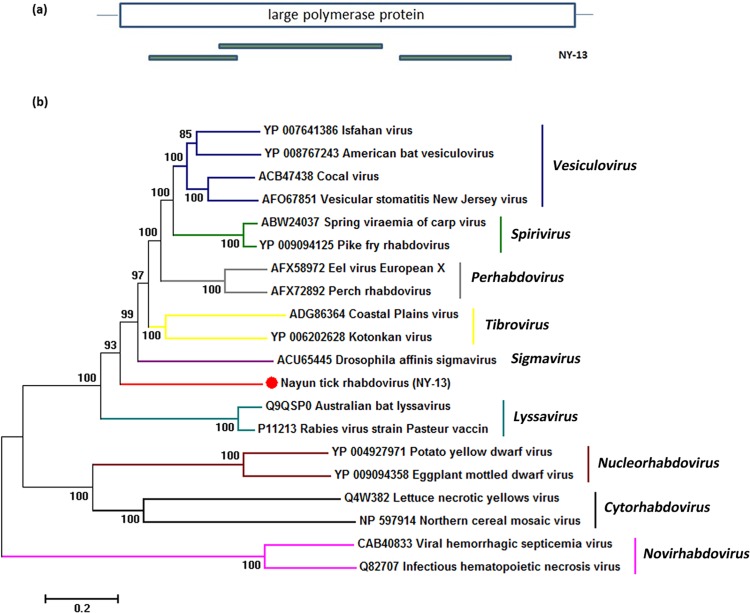
Phylogenetic analysis of tick rhabdovirus-related sequences.(a) Schematic representation of the large polymerase protein of rhabdovirus. The green bar represents the contig sequence from NY-13. (b) Phylogenetic analysis of the selected contig related to rhabdovirus is based on an alignment with an 889 amino acid sequence from the large polymerase protein region of rhabdovirus. All nine Rhabdoviridae genera are indicated on the right of the tree.